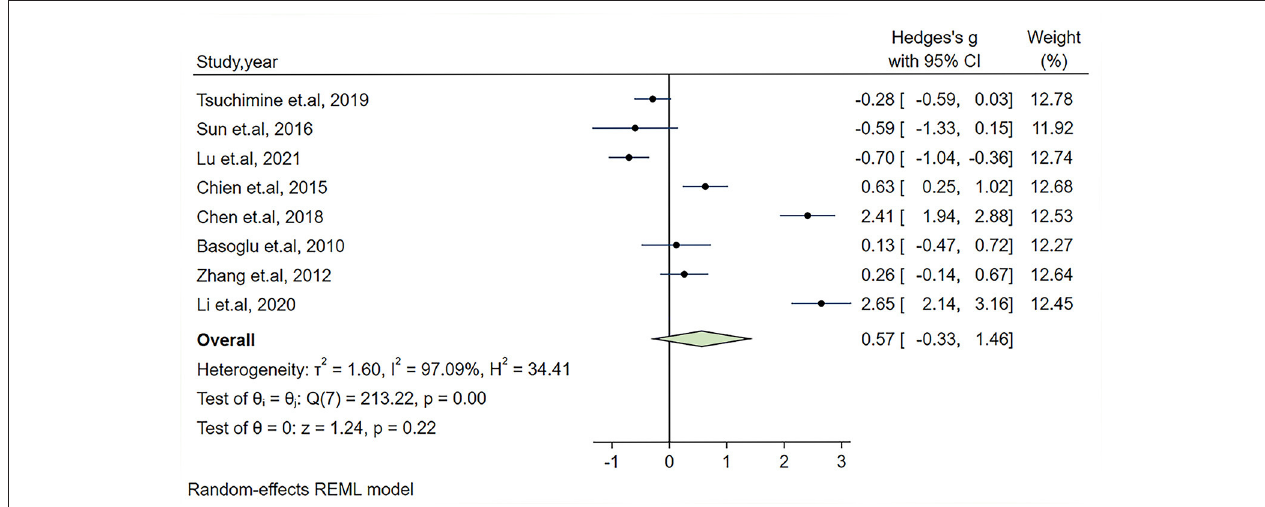
FIGURE 2 | Forest plot of Hedges’s g with corresponding 95% confidence interval (CI) of studies on the association between plasma orexin-A levels and schizophrenia.